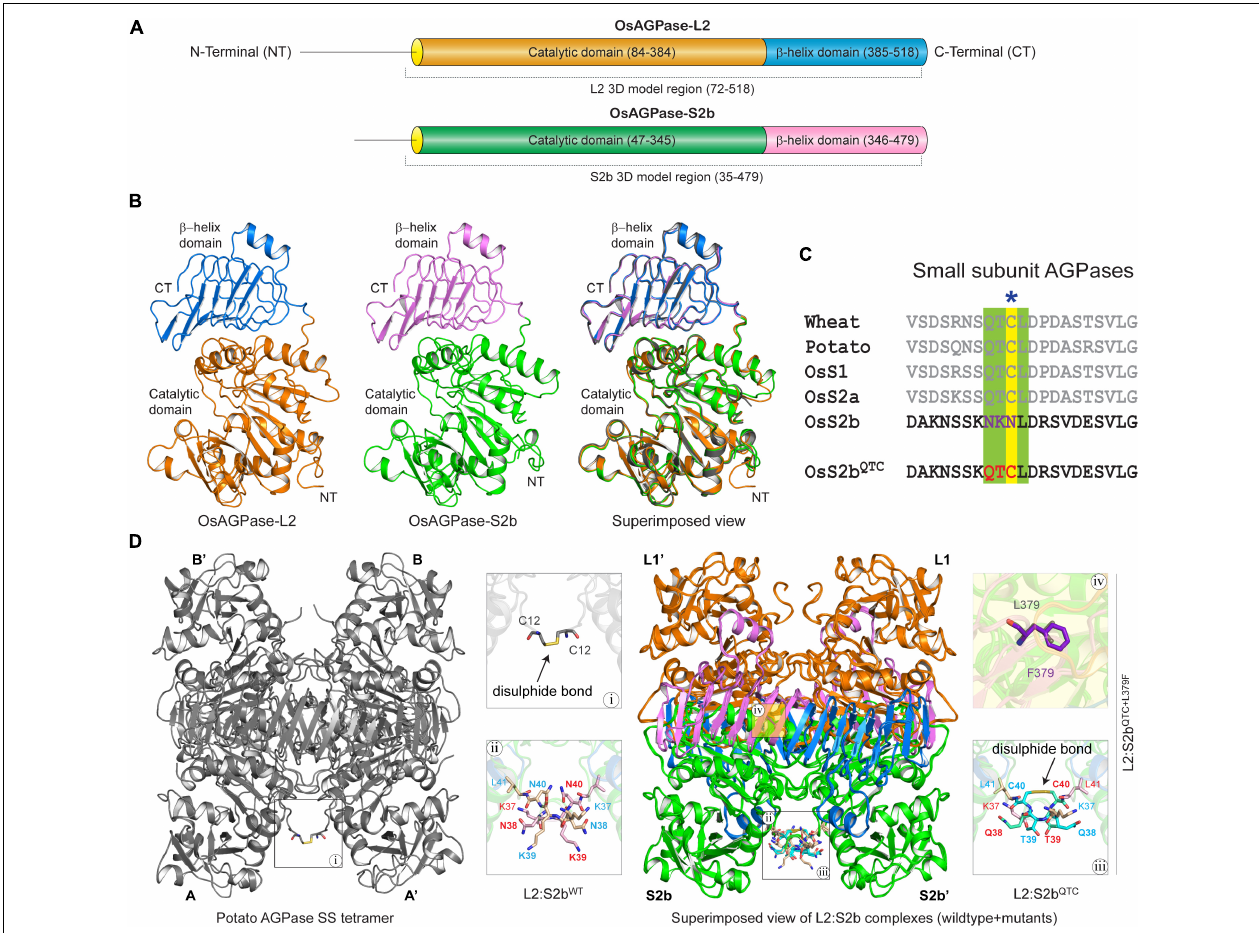
FIGURE 5 | (A) Schematic overview of functional domain regions of rice AGPase subunits. The domain regions and connecting linker of both the AGPases are colored (AGPase-L2: orange, catalytic domain; blue, β -helix domain; OsAGPase-S2b: green, catalytic domain; blue, β -helix domain). (B) 3D models of OsAGPase-L2 and S2b and their superimposed view with potato SS structure. (C) QTCL motifs and inserted QTC in OsS2b shown in multiple sequence alignment of AGPase SSs. (D) Overview of potato SS tetramer and modeled L2:S2b and L2:S2b QTC heterotetrameric complexes. Highlighted in magnifying boxes are: (i) Cys–Cys disulfide bond in potato SS; (ii) Asn-Lys-Asn peptide at the N-terminus of rice AGPase; (iii), Cys–Cys disulfide bond between S2b QTC ; (iv) L379F mutation on S2b QTC + L379F